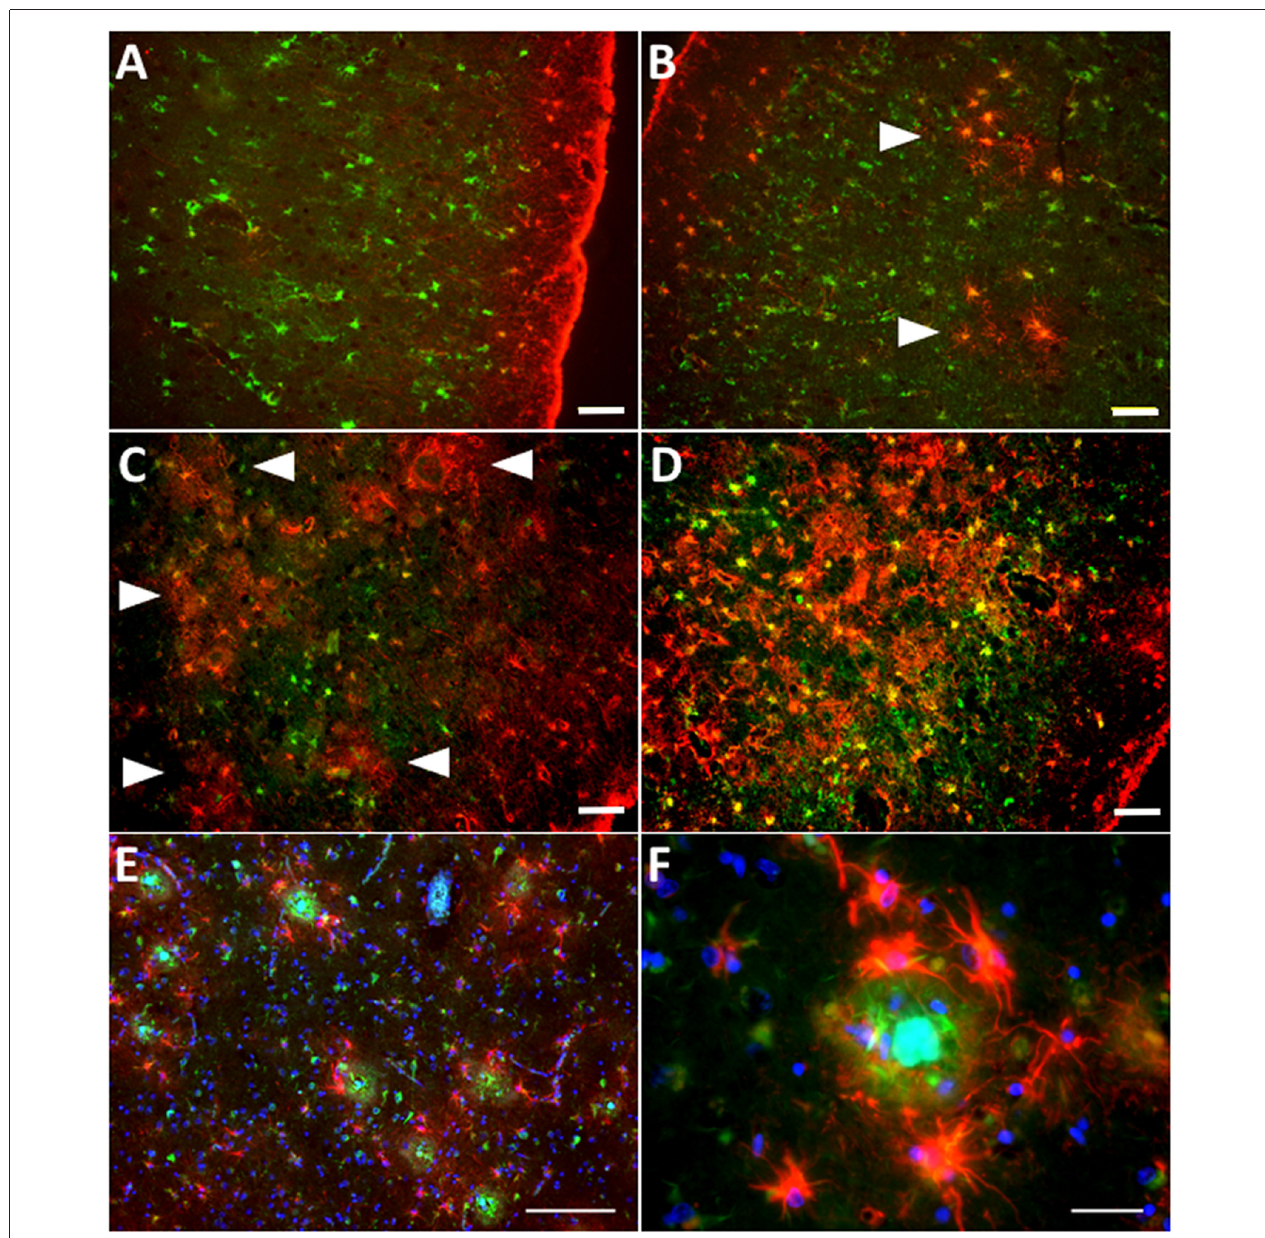
FIGURE 3 | Astrocyte reaction to amyloid plaques in the Alzheimer’s brain. (A–D) Double fluorescent immunohistochemistry for GFAP (red) and the enzyme glutamine synthetase (green) showing the progression of astrocyte reaction (defined by GFAP immunoreactivity) in the temporal association neocortex (Brodmann’s area 38) of a healthy control subject without Alzheimer’s disease (AD) changes (A) , another healthy control individual with sparse neuritic plaques (B) , and two patients with an AD diagnosis (C,D) . Arrowheads point to increasingly numerous clusters of GFAP-immunoreactive astrocytes, which become confluent in advanced stages of the disease. (E) Clusters of GFAP-immunoreactive astrocytes (red) surrounding dense-core amyloid plaques (Thioflavine-S positive, green) in the temporal association neocortex (Brodmann’s area 38) of an AD patient. (F) GFAP-immunoreactive astrocytes penetrate and surround dense-core amyloid plaques with their processes. Scale bars: 50 µ m in (A–D) , 100 µ m in (E) , and 10 µ m in (F) .